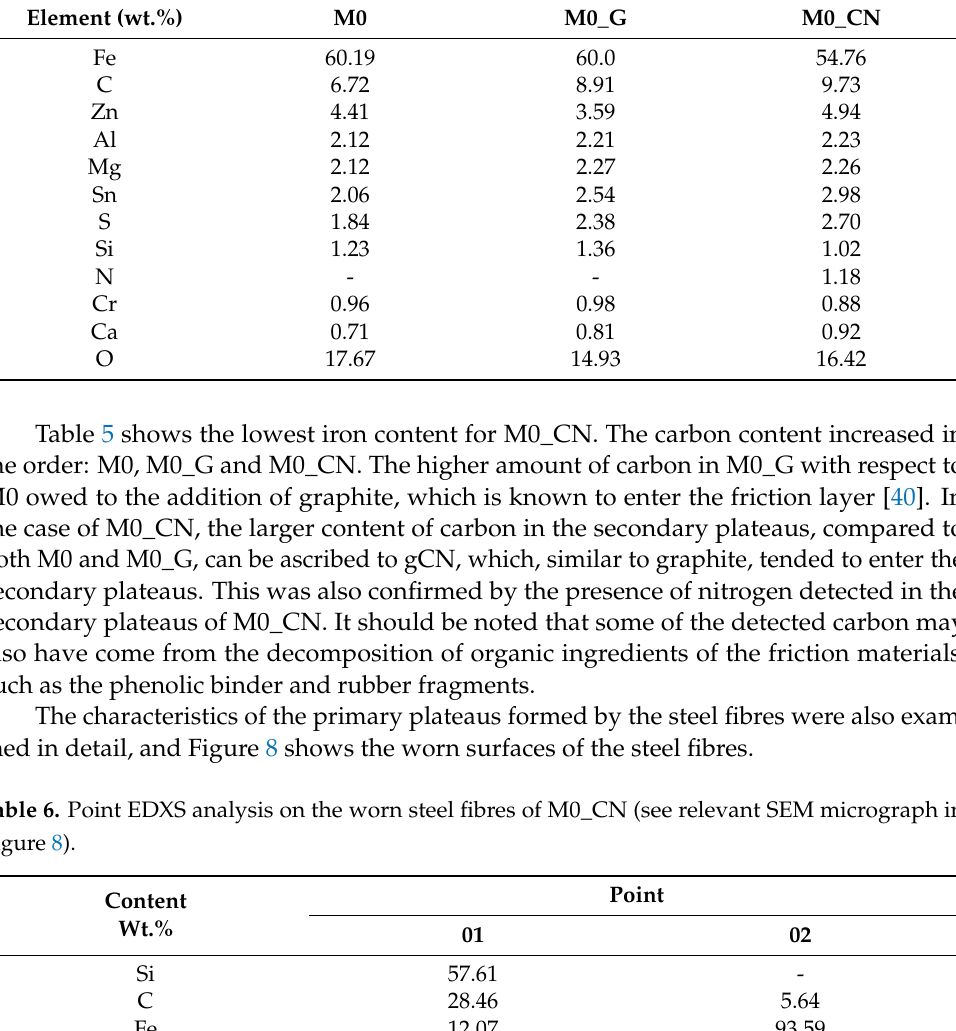
Table 5. Elemental composition (EDXS) of secondary plateaus on the pin surfaces. Element (wt.%)